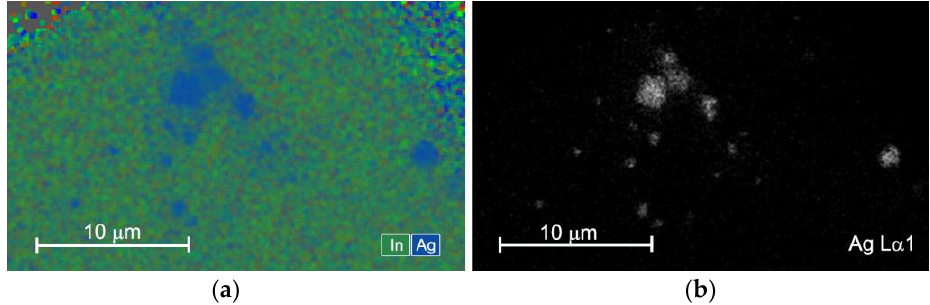
Figure 5. ( a ) HAADF-STEM image and ( b ) energy dispersive X-ray (EDX)maps of In 2 O 3 /Ag-imp nanocomposite.